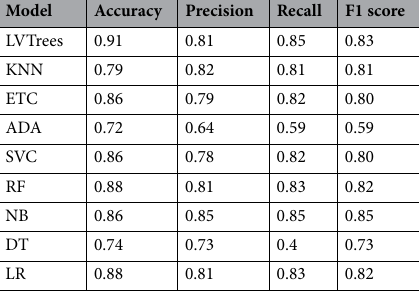
Table 13. Performance of models after applying Chi2 technique.